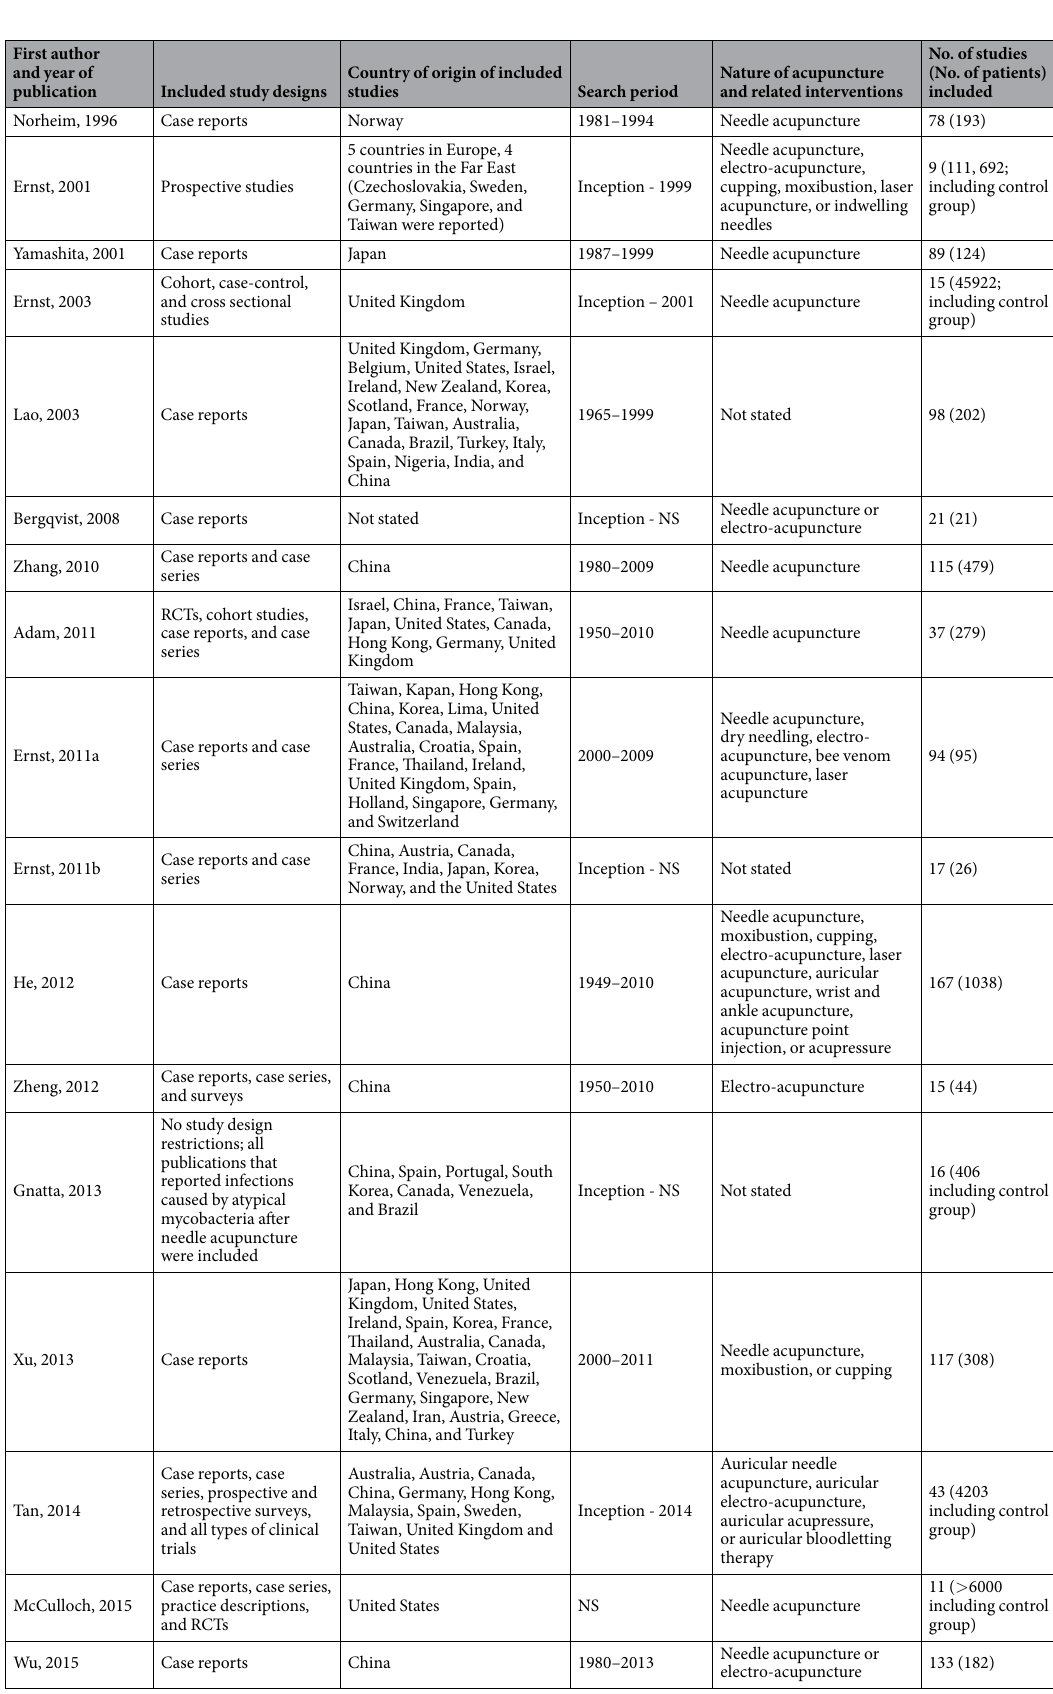
Table 1. Characteristics of included systematic reviews on acupuncture related adverse